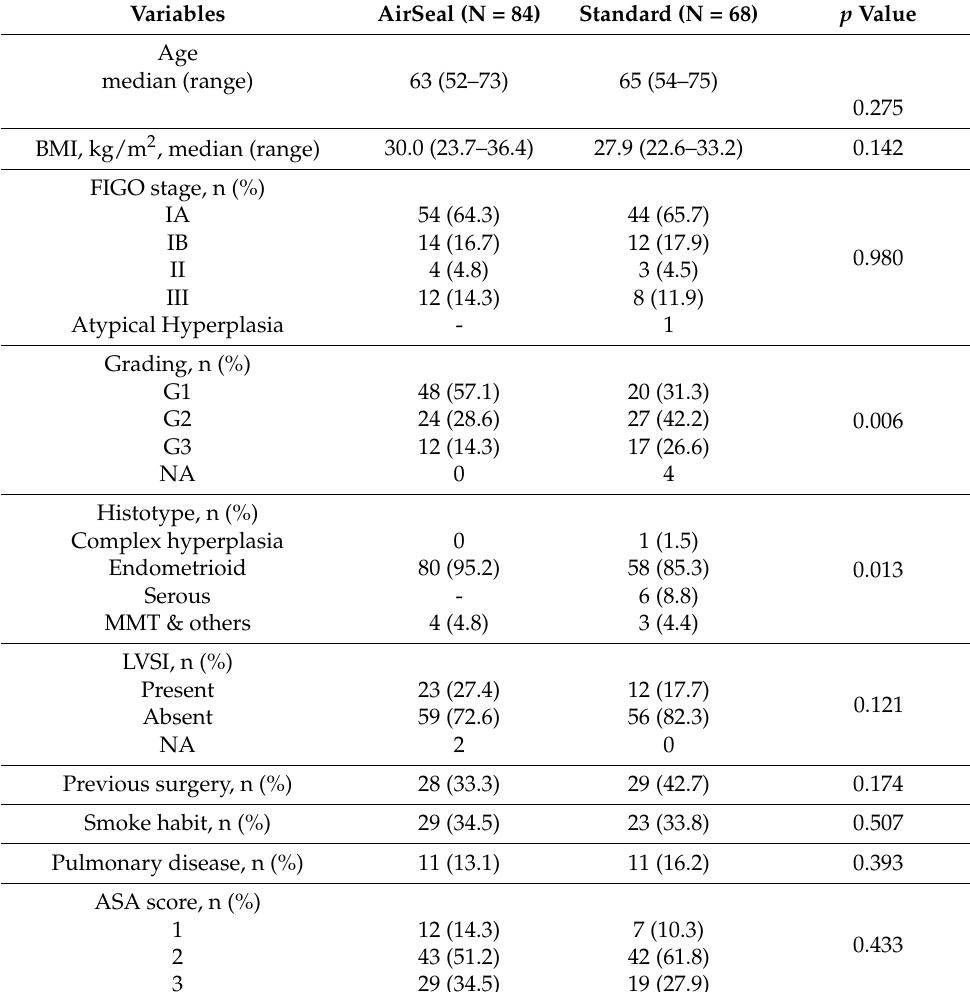
Table 1. General characteristics of the study